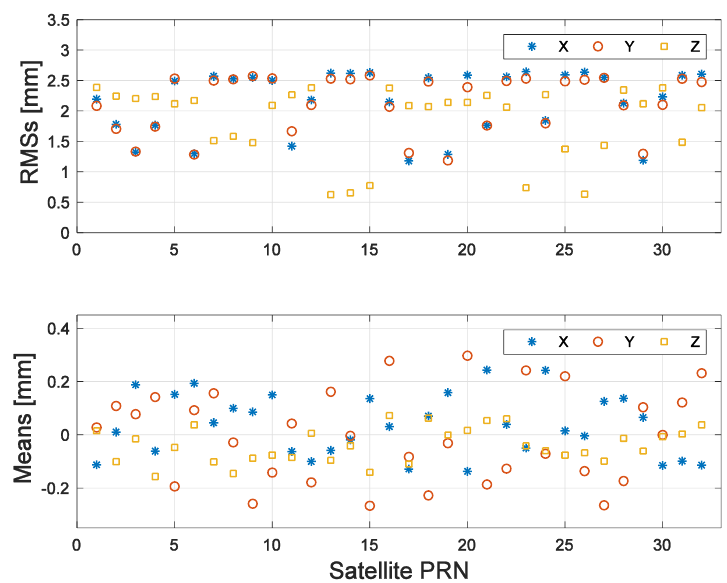
Figure 1. The means (bottom) and RMSs (top) of the computed GPS satellite position (STP) errors, with one-day final 30-s International GNSS Service (IGS) GPS ephemeris products as the “true” value, with 30-s sampling intervals.